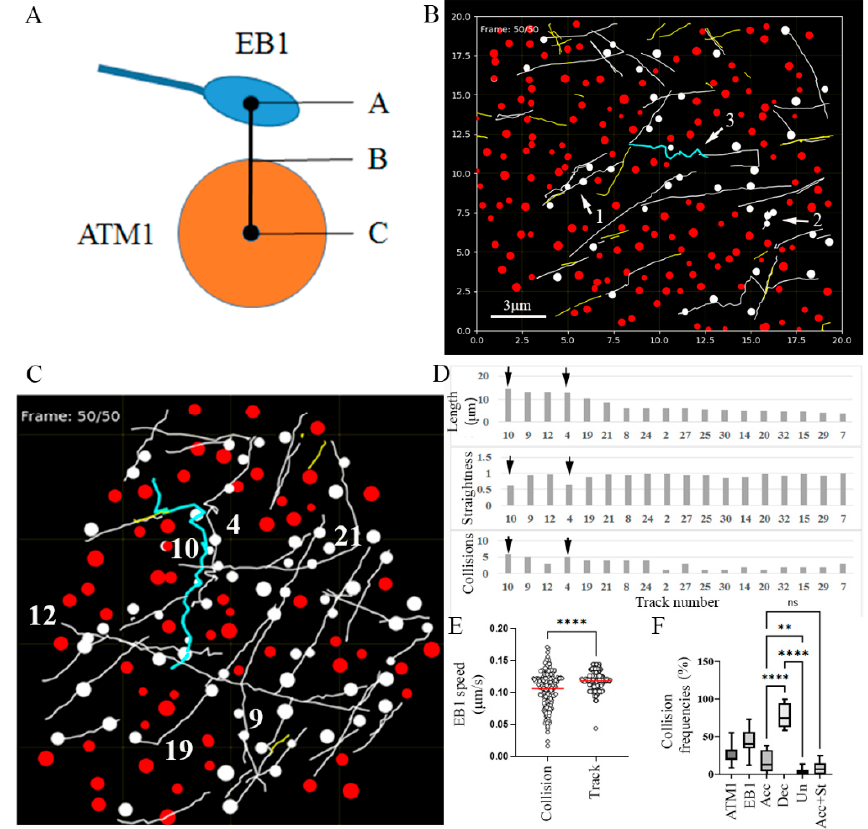
Figure 5. A software program developed in Python that simulates MTs–ATM1 IQ-tail collisions. ( A ) Scheme showing the concept of the simulation: coordinates of the positioning of each ATM1 IQ-tail cluster or EB1b spot were extracted from Imaris. A collision was counted when the distance from A to B was ≤ 100 nm. ( B ) Snapshot of animation based on Movie S5. Spots of ATM1 IQ-tail that experience MTs collision and the colliding track turned white. A selected track was colored. Arrows indicate three of the four scenarios: (1) pass through, (2) pause and disappear, (3) wave and change direction. Scale bar = 3 μ m. ( C – E ) A comparison of all tracks by a single cell analysis. ( C ) Snapshot of the last frame of the animation (Movies S8 and S9) showing, in white, tracks and spots that experienced collisions. The numbers show the six longest tracks. Track 10 which experienced maximum collisions is colored. ( D ) Summary of length, straightness and number of collisions for all tracks above 5 μ m in length. Arrows show tracks 10 and 4 as being the least straight. ( E ) EB1b speed in frames − 1 to +3 around every collision compared to the average speed along the whole track. The graph shows results from the cell presented in panel ( C ). Differences were determined by t -test p < 0.0001. ( F ) Collisions frequencies calculated in 20 cells; ATM1-percent ATM1 IQ-tail spots experienced collisions, EB1-percent colliding tracks, Acc-percent tracks with accelerated speed after a collision. Dec-percent tracks with decelerated speed after a collision. Un-percent tracks with unaffected speed. Acc + str-percent tracks with accelerated speed associated with decreased straightness. ** p < 0.01, **** p < 0.0001 one way ANOVA. ns = not significant.